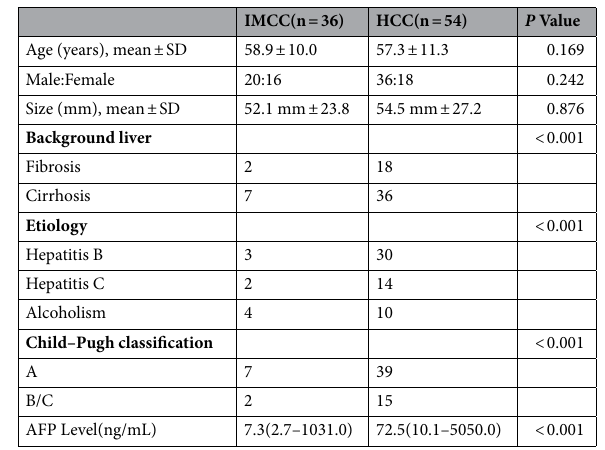
Table 1. Clinical characteristics of patients with IMCC and HCC. IMCC intrahepatic mass-forming cholangiocarcinoma, HCC hepatocellular carcinoma, SD standard deviation, AFP a-fetoprotein.